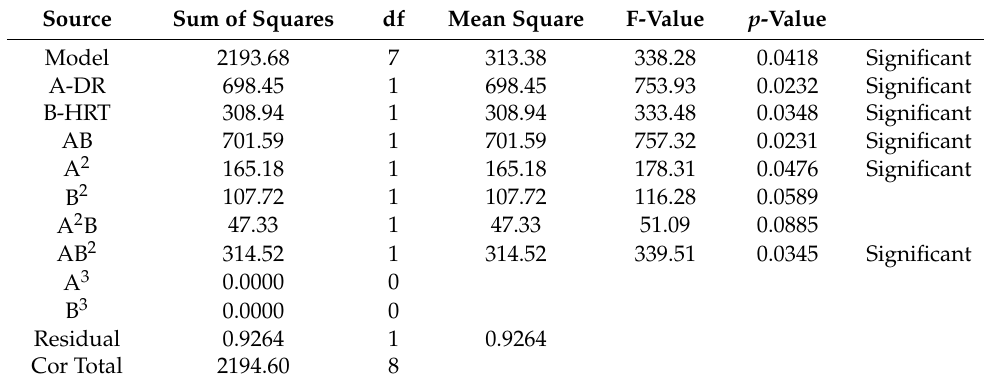
Table 5. ANOVA for cubic model response 1: EPR.